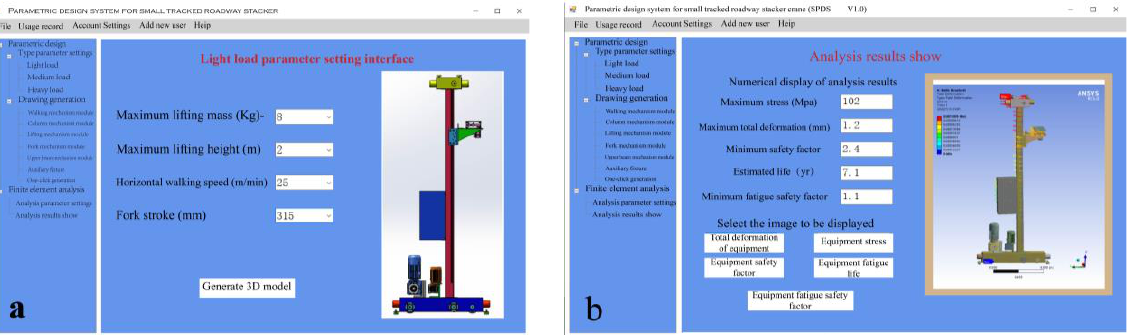
Figure 8. ( a ) Software result engineering drawing interface, and ( b ) software analysis results display interface.